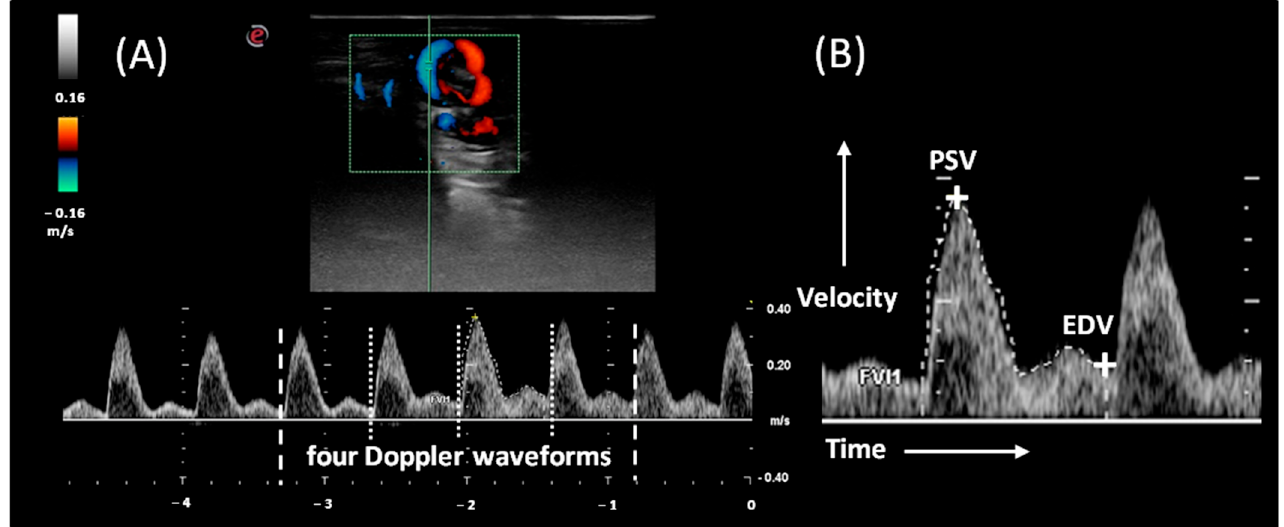
Figure 2. Schematic view of the blood flow measures. The pulse wave Doppler ultrasound images of the testicular artery in the spermatic cord ( A ) with a single Doppler waveform (dropped line separation) formed four Doppler waveforms selected for evaluation (dashed line separation). Sample Doppler waveform with marked the peak systolic velocity (PSV) and end-diastolic velocity (EDV) ( B ).